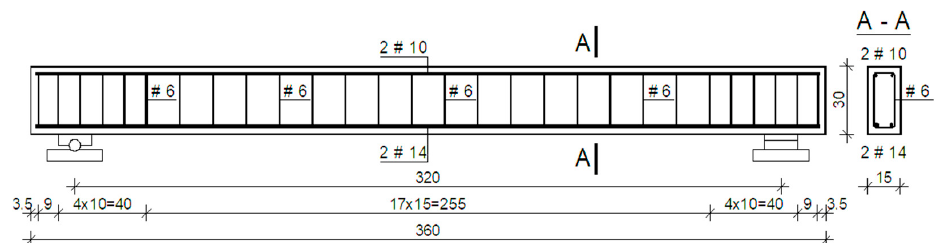
Table 5. Description of test specimens.